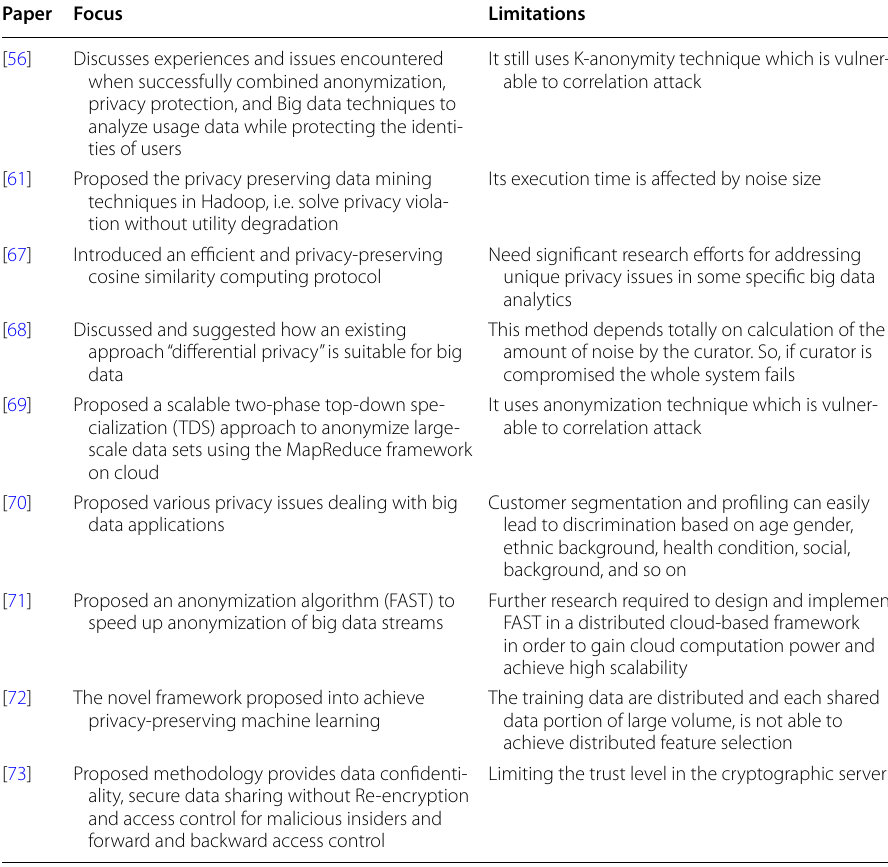
Table 5 Summary on recent approaches used in big data privacy Paper